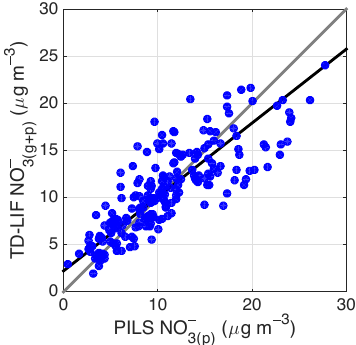
Figure A1. P-3B TD-LIF NO − in PM 2 . 5 versus PILS NO − 3 ( g + p ) 3 in PM 3 below 0.5kma.s.l. The gray line is one-to-one and the black line is a least squares fit assuming equal weights in x and y